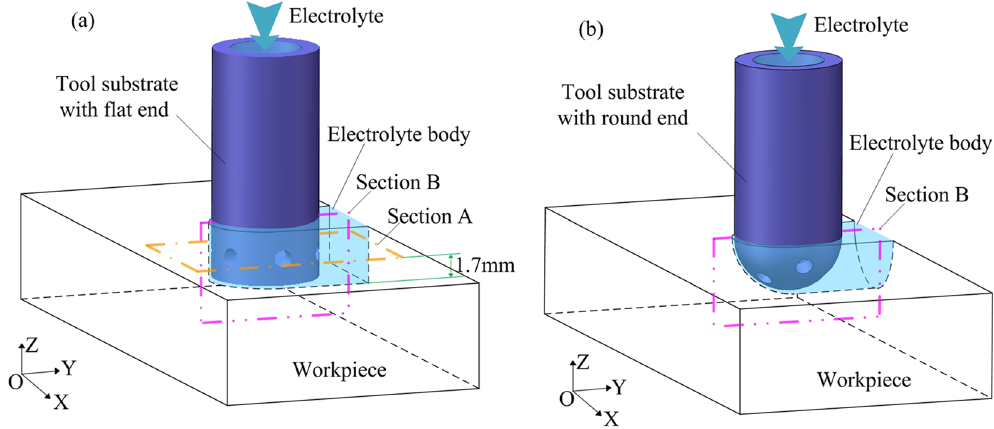
Figure 2. Electrolyte bodies in the flow-field simulation: ( a ) flat-ended tool tube; ( b ) round-ended tool